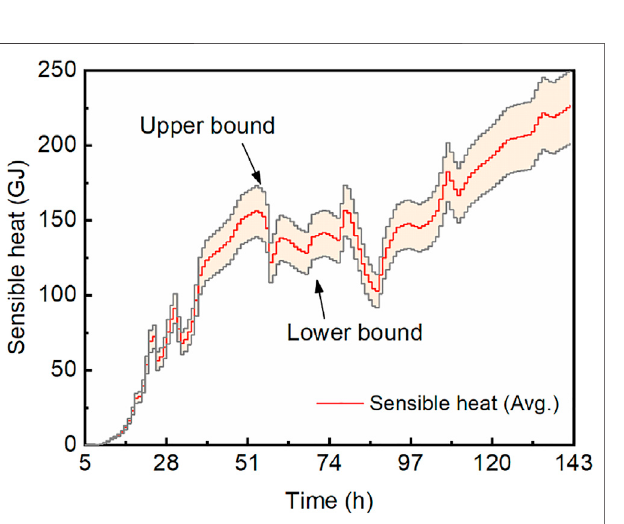
FIGURE7| Comparison ofthetotalgasproduction (black solidline)and the calculated hydrate-released gas production (dashed-dotted lines) and the real-time ratio of hydrate-released gas to gas production (red solid